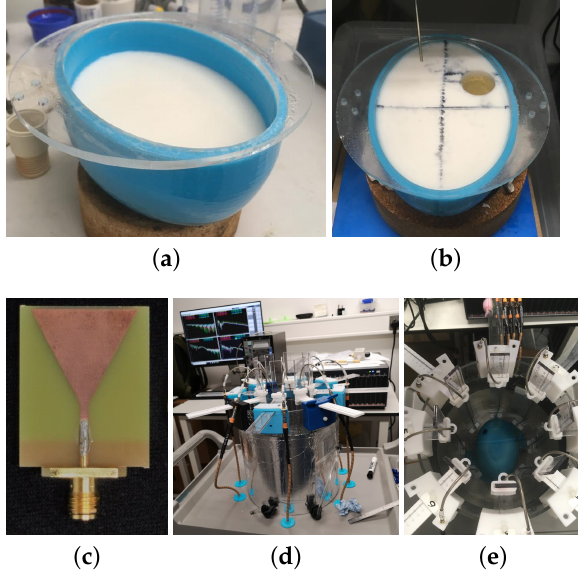
Figure 3. Photos of the experimental head phantom ( a , b ), antenna ( c ) and system ( d , e ) used to validate the 3-D DBIM-FISTA algorithm. Details of the setup and experiment can be found in [54]. The phantom is made of a 3D-printed plastic mould and is filled with an “average brain tissue” material with ε r ≈ 41.6 − 5.9 j at 1.0 GHz. We should note that the permittivity of the brain tissue differs at different positions, i.e., the permittivity near the different surface, in the inner parts or near the bottom has different values [54]. The brain phantom is immersed in the 90–10% glycerol-water mixture inside an imaging tank, which is made of acrylic and is surrounded by absorbing material ECCOSORB MCS covered by a metallic shield. A printed monopole triangular patch antenna is used, as shown in Figure 3c, which operates well in the frequency range 0.5–2 GHz [55]. An eight-antenna array inside the tank captures MWT data with the help of an eight-port VNA system embedded in the Keysight M9019A PXIe Chassis connected to a desktop, shown in Figure 3d,e. Further details of the experimental system and the process of making the phantom can be found in